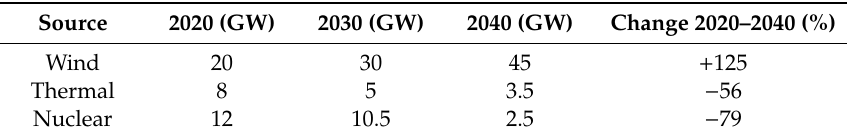
Table 1. Power generation in the NPS in the period 2020–2040 [2].